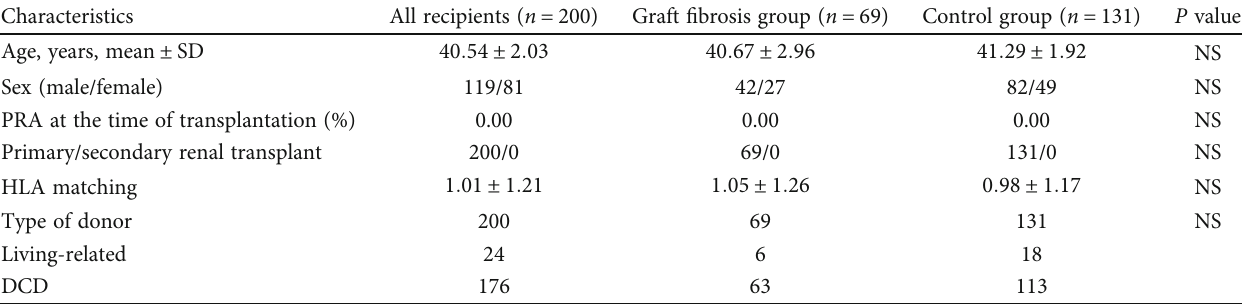
Table 1: Baseline characteristics of included recipients in our study.